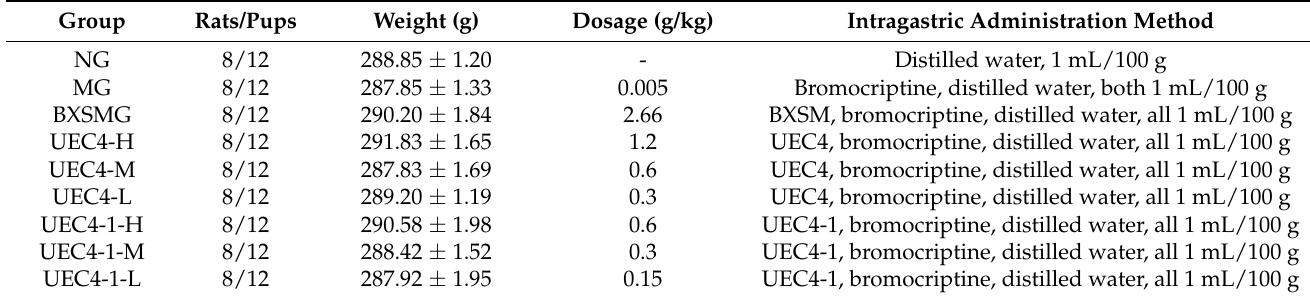
Table 1. Grouping and treatment of female